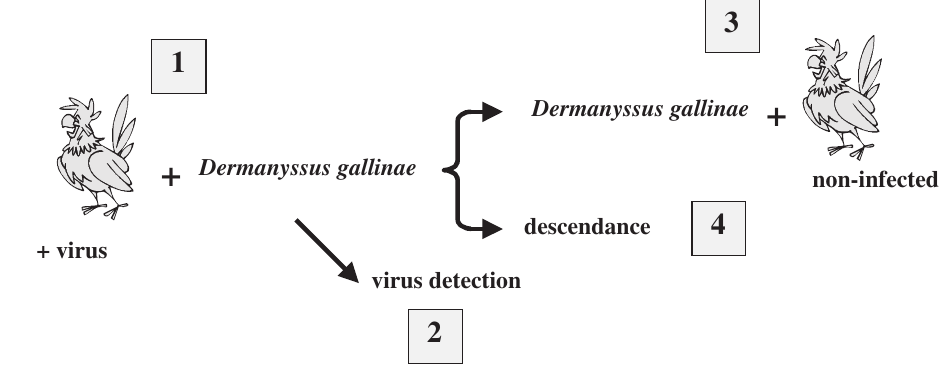
Fig. 2. – General methods to asses the vector role of dermanyssoid mites in equine encephalitis caused by togavirus. Acarians feed on a previously infected host (1) and are then tested for the presence of the virus (2). They are then allowed to feed on a non-infected host so that the possible viral transmission could be studied (3). Offspring were also analysed